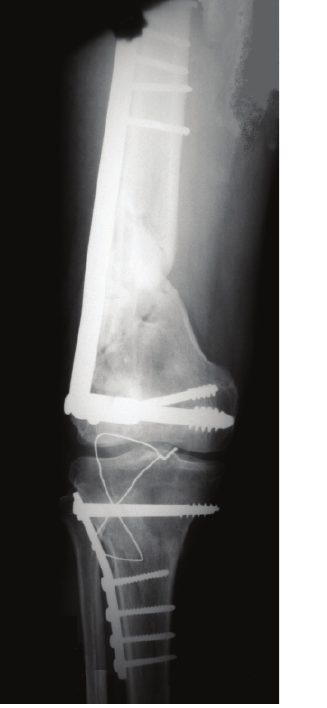
Figure 6: 3-month followup X-ray of the right knee AP showing fracture union.